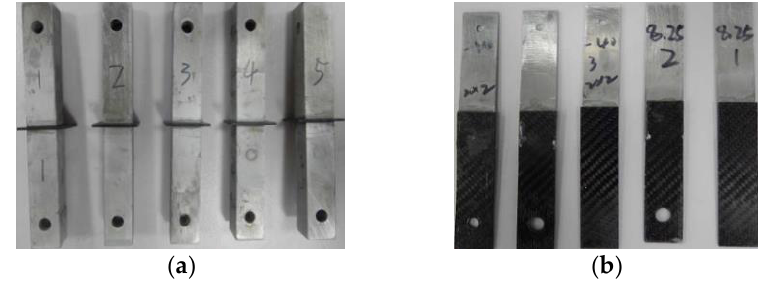
Figure 9. Test specimen: ( a ) Butt tensile specimen; ( b ) Lap shear specimen.